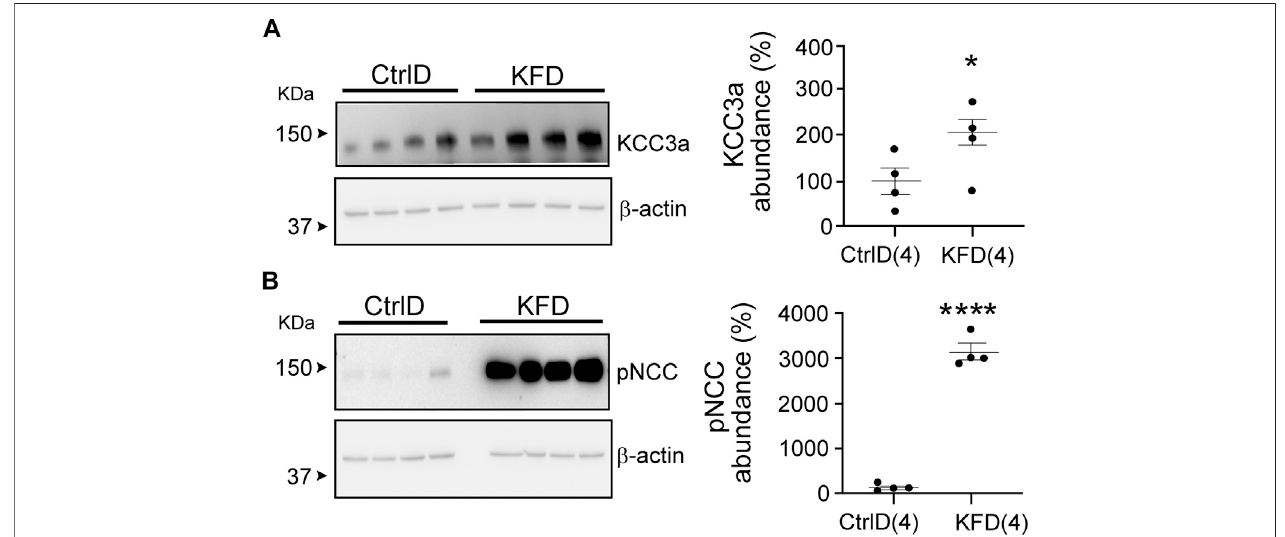
FIGURE4| Changeinpotassiumchloridecotransporter3a(KCC3a)abundanceinthekidneyinmiceonK + -de fi cientdiet. (A) KCC3aabundanceincreasedonK + - freediet(KFD)thaninthecontrol(Ctrl)diet(two-tailedunpaired t -test). (B) Thephosphorylatedsodiumchloridecotransporter(pNCC)abundancewashigherontheKFD than on the control diet (two-tailed unpaired t -test), indicating the diet ’ s ef fi ciency. For blot quanti fi cation, densitometric values were normalized to β -actin. Values are means ± SEM; values in parentheses indicate n values. * p < 0.05; **** p < 0.0001.